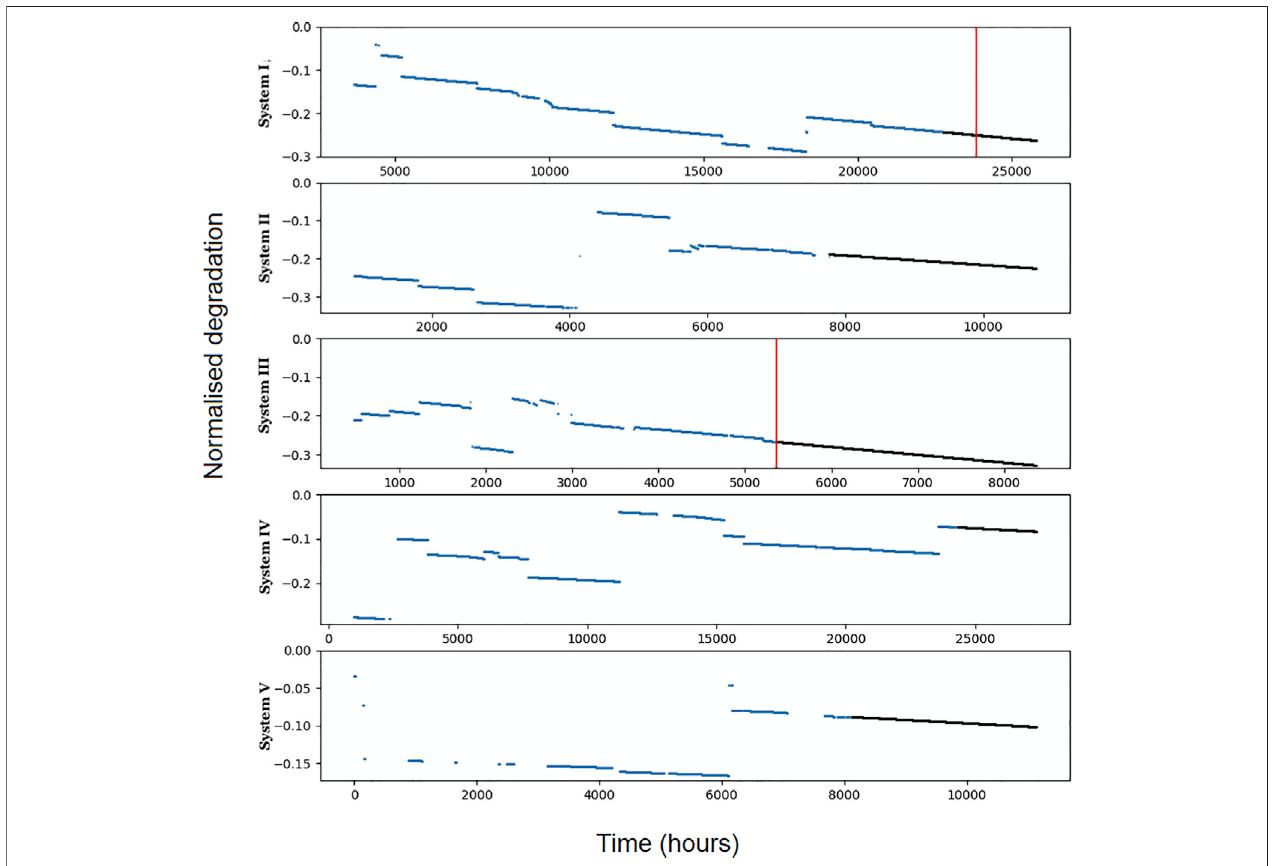
FIGURE 6 | Engine degradation and maintenance suggestion for different micro-GT units (Olsson et al., 2021).